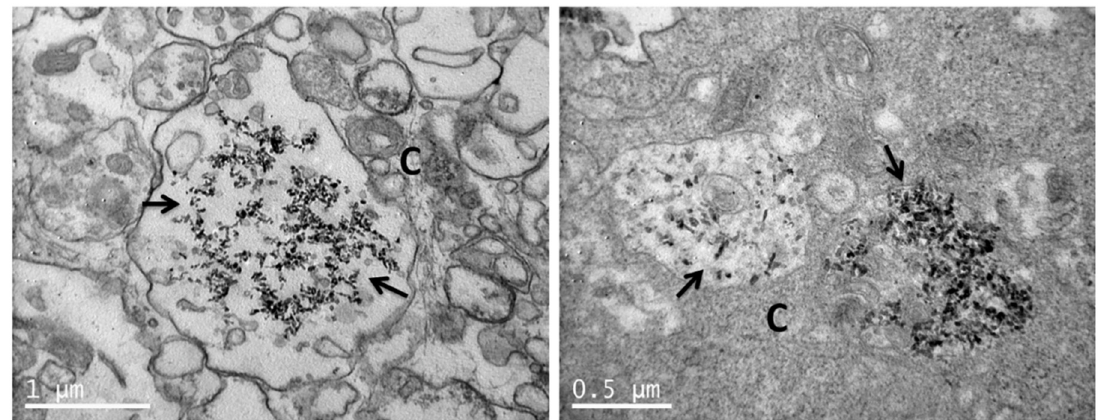
Figure 10. Representative TEM images showing nHA-2 uptaken by pre-osteoblastic cells. Nanoparticles of nHA-2 are shown localized in the intracellular space in vesicles (in other images that are not shown, they appear also in the extracellular space). The scale bar represents 1 μ m (left) and 0.5 μ m (right). The letter C designates the cytoplasm, and the arrows depict the nanoparticulated sample nHA-2.